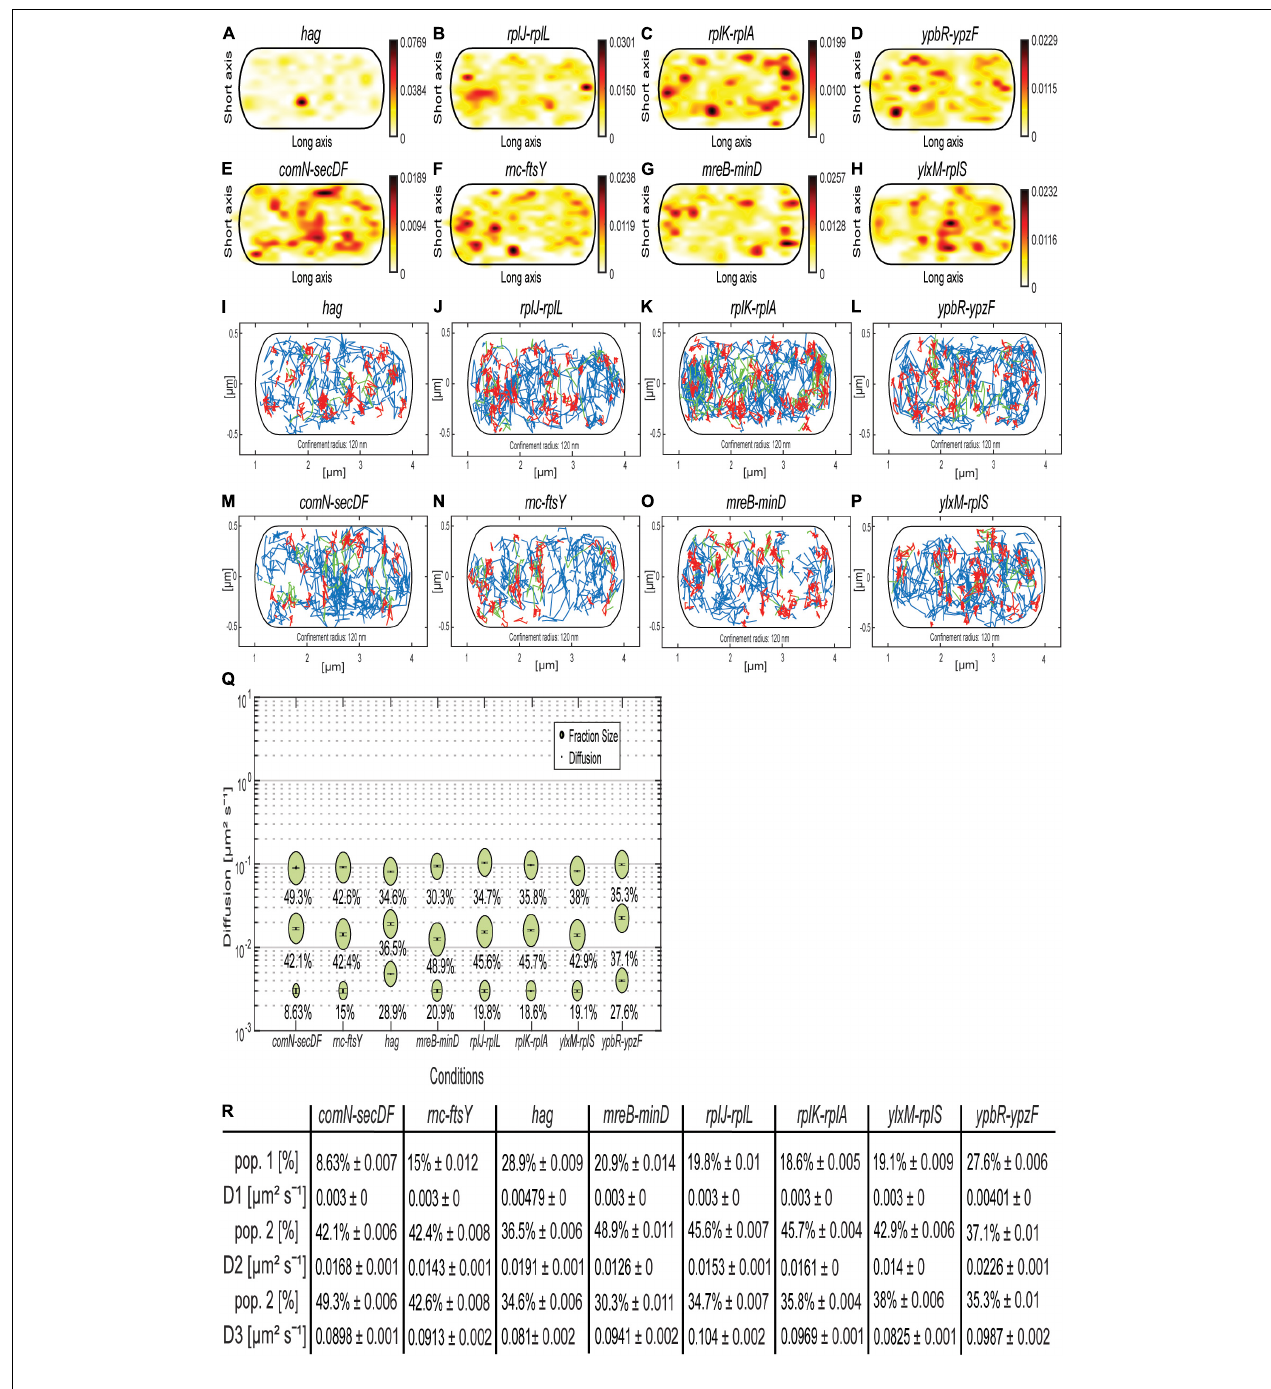
FIGURE 8 | Artificially extended mRNAs approximately 1,700 bp longer than native mRNAs, with one MS2-binding site, behave similar to native mRNAs with two MS2-binding sites. (A–H) Heat maps. (A–D) are mRNAs for soluble proteins, and (E–H) for membrane-associated or membrane proteins. From white to red is the low to high probability of localization. (A) MS2-mVenus + hag _MS2–binding site 1 × , (B) MS2-mVenus + rplJ-rplL _MS2–binding site 1 × , (C) MS2-mVenus + rplK-rplA _MS2–binding site 1 × , (D) MS2-mVenus + ypbR-ypzF _MS2–binding site 1 × , (E) MS2-mVenus + comN-secDF _MS2–binding site 1 × , (F) MS2-mVenus + ftsY _MS2–binding site 1 × , (G) MS2-mVenus + mreB-minD _MS2–binding site 1 × , and (H) MS2-mVenus + ylxM-rplS _MS2–binding site 1 × . (I–P) Confinement maps. Blue freely diffusive tracks, red confined tracks (120-nm circle, minimum of eight steps), and green tracks with mixed behavior. (I–L) mRNAs for soluble proteins, (M–P) for membrane-associated or membrane proteins. (I) MS2-mVenus + hag _MS2–binding site 1 × , (J) MS2-mVenus + rplJ-rplL _MS2–binding site 1 × , (K) MS2-mVenus + rplK-rplA _MS2–binding site 1 × , (L) MS2-mVenus + ypbR-ypzF _MS2–binding site 1 × , (M) MS2-mVenus + comN-secDF _MS2–binding site 1 × , (N) MS2-mVenus + ftsY _MS2–binding site 1 × , (O) MS2-mVenus + mreB-minD _MS2–binding site 1 × , and (P) MS2-mVenus + ylxM-rplS _MS2–binding site 1 × . (Q) Bubble plots showing fraction size and diffusion constants of tested mRNAs. (R) Corresponding table showing population size and diffusion constants.